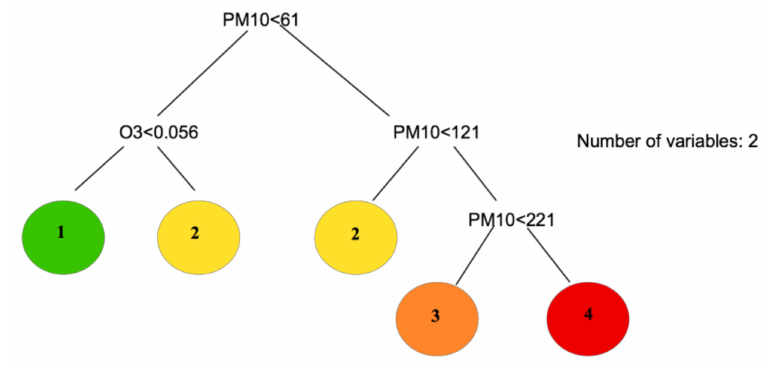
Figure 4. Training results using machine learning applying the CART classification